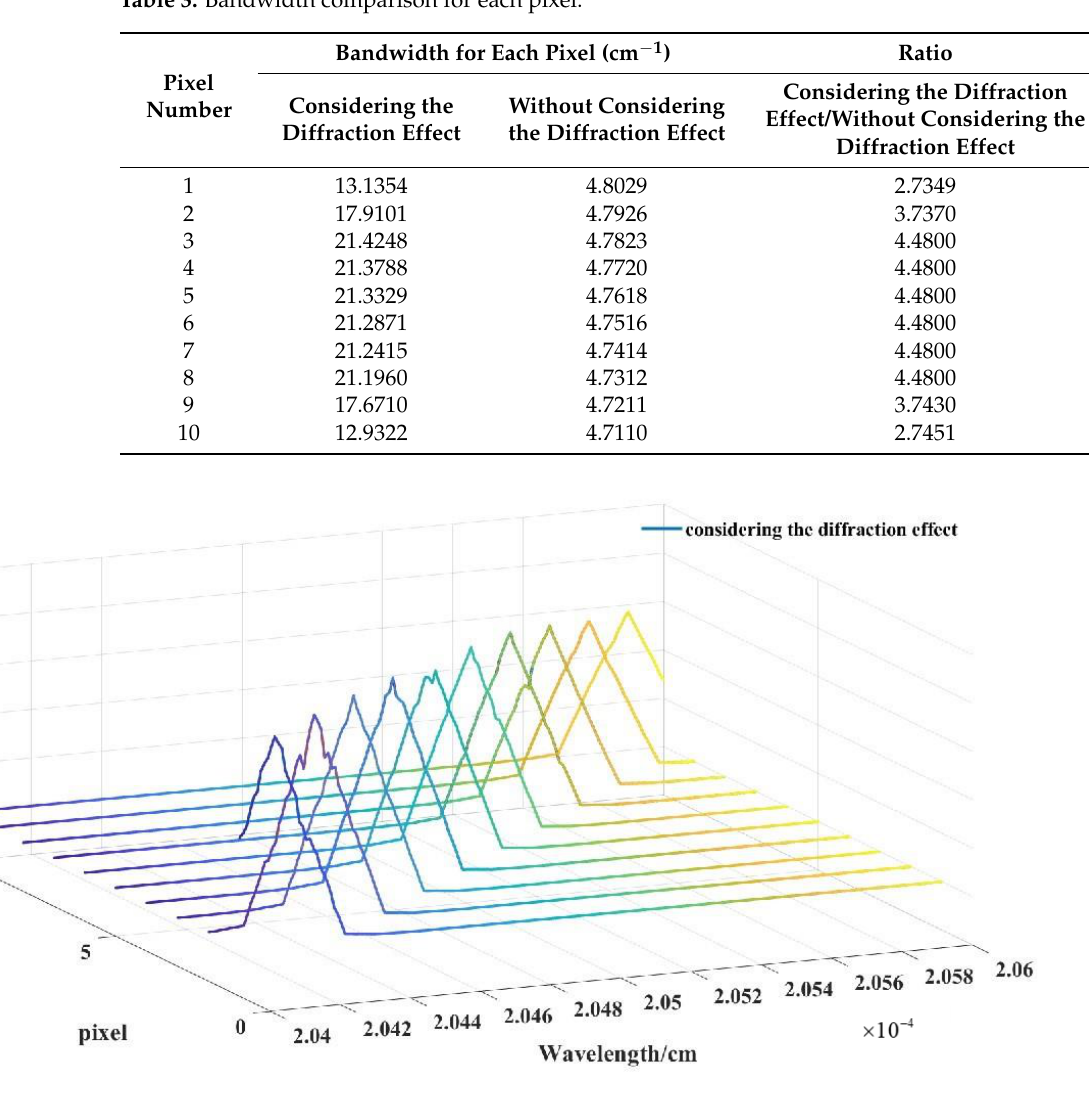
Table 4. Comparison of OPD sampling step for each pixel.